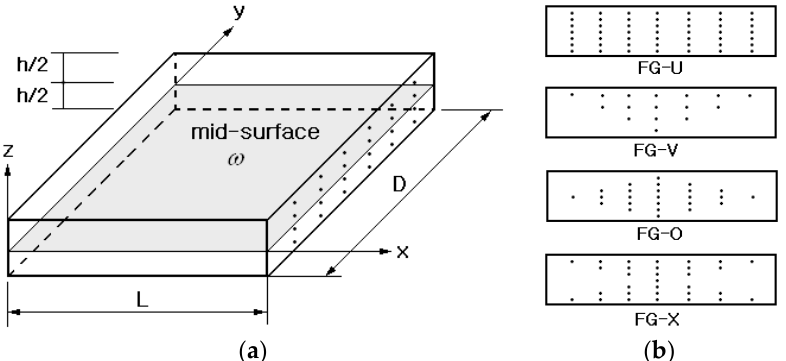
Figure 1. A carbon-nanotube-reinforced composite (CNTRC): ( a ) geometry and dimensions; ( b ) four functionally graded (FG) distributions.